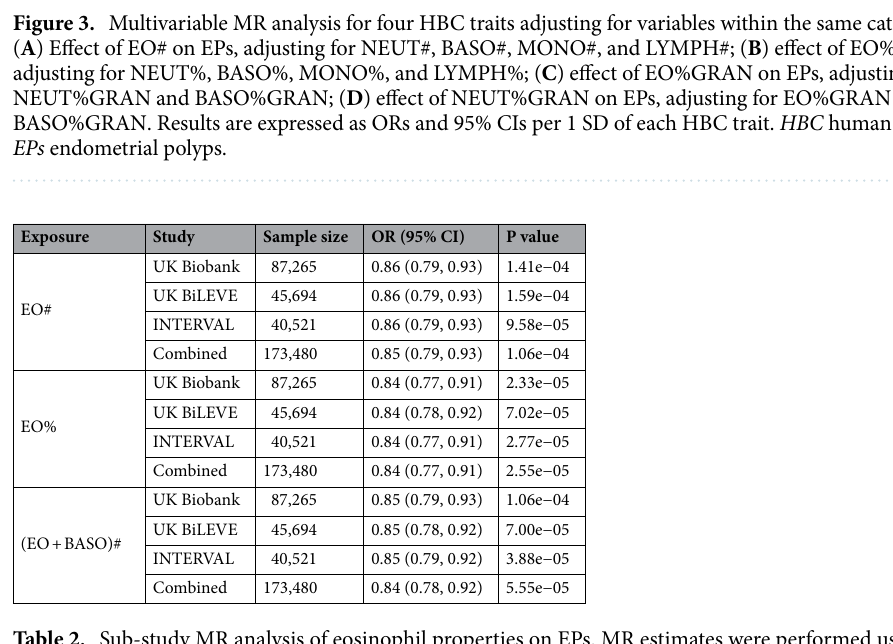
Table 2. Sub-study MR analysis of eosinophil properties on EPs. MR estimates were performed using samples separately from UK Biobank, UK BiLEVE and INTERVAL. Associations were assessed using the random-effect IVW method. Results are expressed as ORs and 95% CIs per 1 SD of each HBC trait. EPs endometrial polyps, IVW inverse-variance